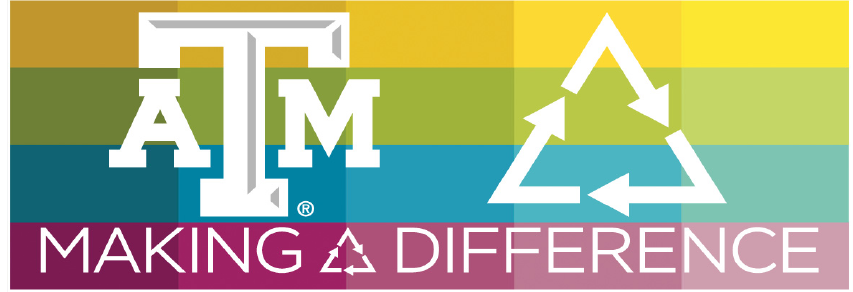
Figure 6. Sample of Utilities and Energy Services Recycling